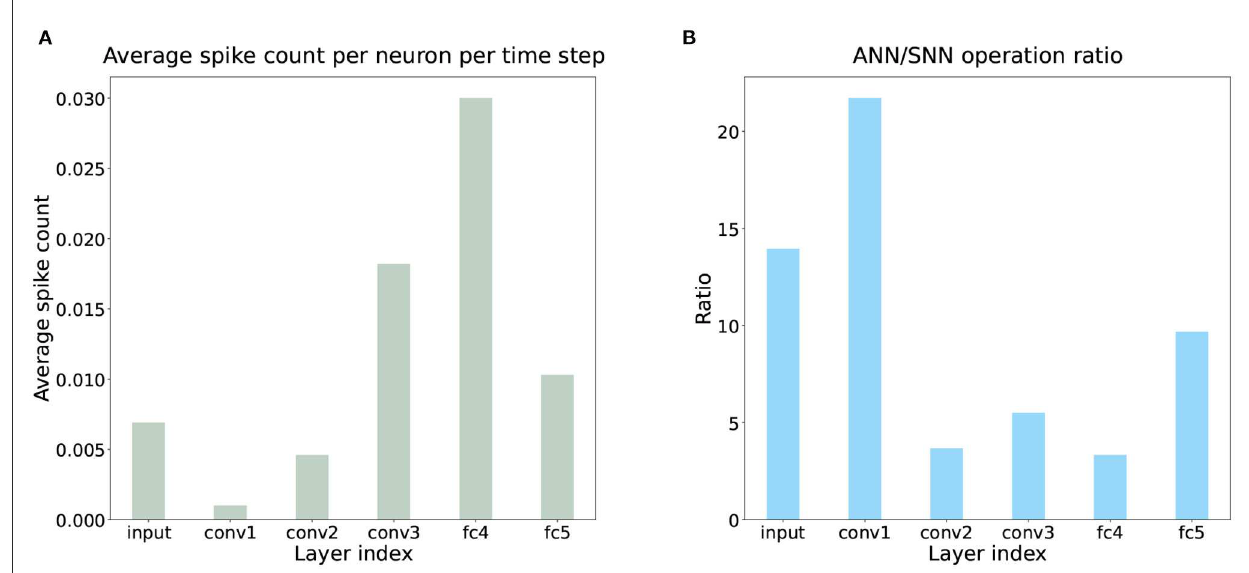
FIGURE8 (A) Average spike count per neuron per time step of the trained SCTN on DVSOT21. It is shown that the neuronal activities of all network layers are sparse in the entire time window, which leads to the very low energy consumption of SCTN in Table 3. (B) The operation ratio of ANN/SNN in the same network structure.